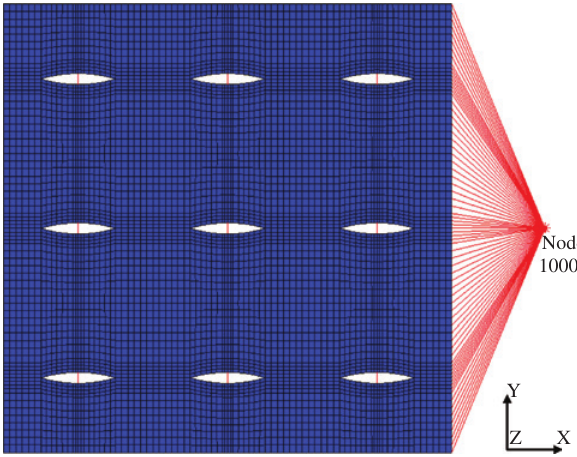
Figure 7: The 9-cell model.